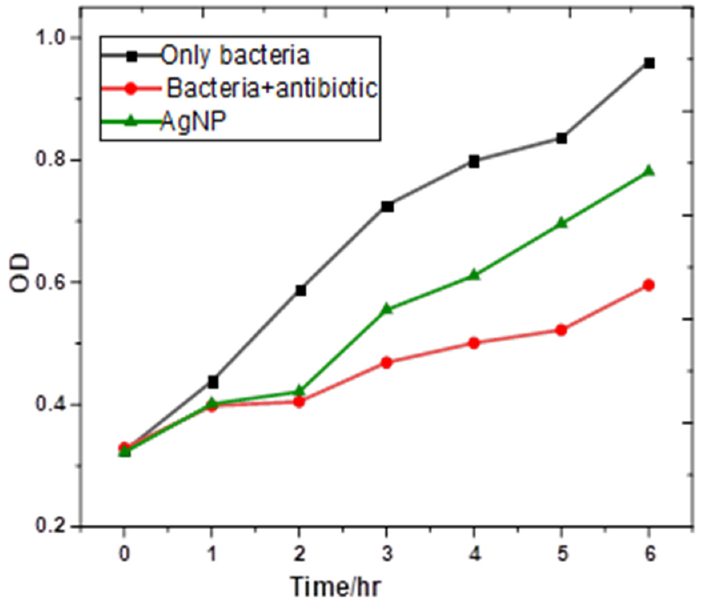
Figure 7. The growth curves of Pseudomonas aeruginosa after exposure to AgNP functionalized by Teucrium extract are displayed, along with a comparison of Ag-NPs to an antibiotic (imipenem 10 ug, red curve) over the duration of 1–6 h ( p < 0.05). The control sample (black curve) contains only bacteria, without AgNPs.